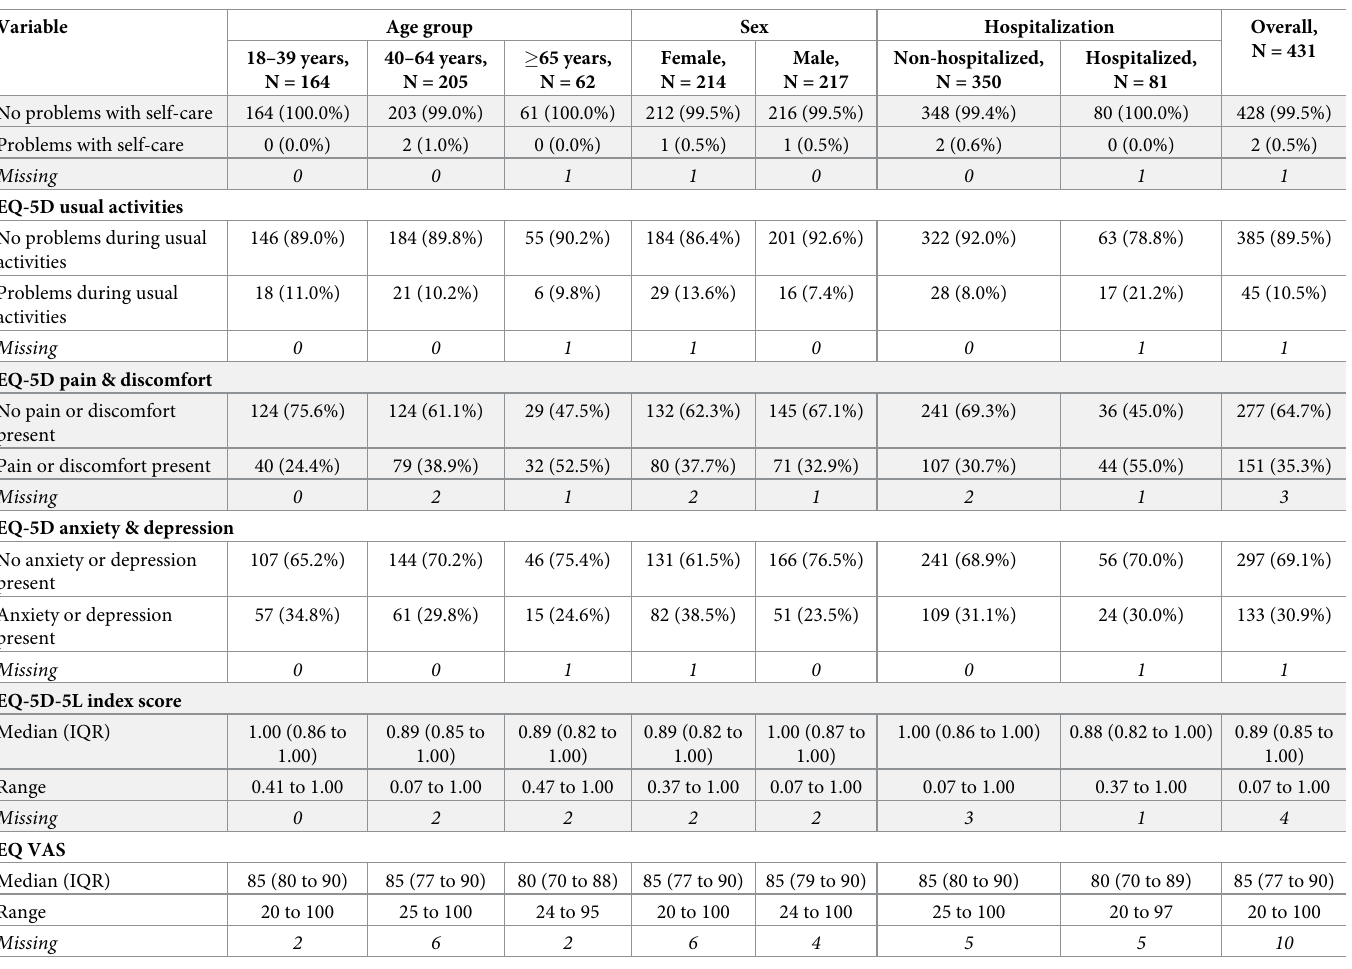
(Table 2). We observed a higher percentage of grade � 1 dyspnea among older age individuals, females, and initially hospitalized participants. In multivariable analyses, we found evidence for an association of grade � 1 dyspnea with female sex, initial hospitalization, higher body mass index and presence of comorbidities, but not for initial symptom severity, smoking status or presence of a chronic respiratory condition (Fig 2 and S4 Table).